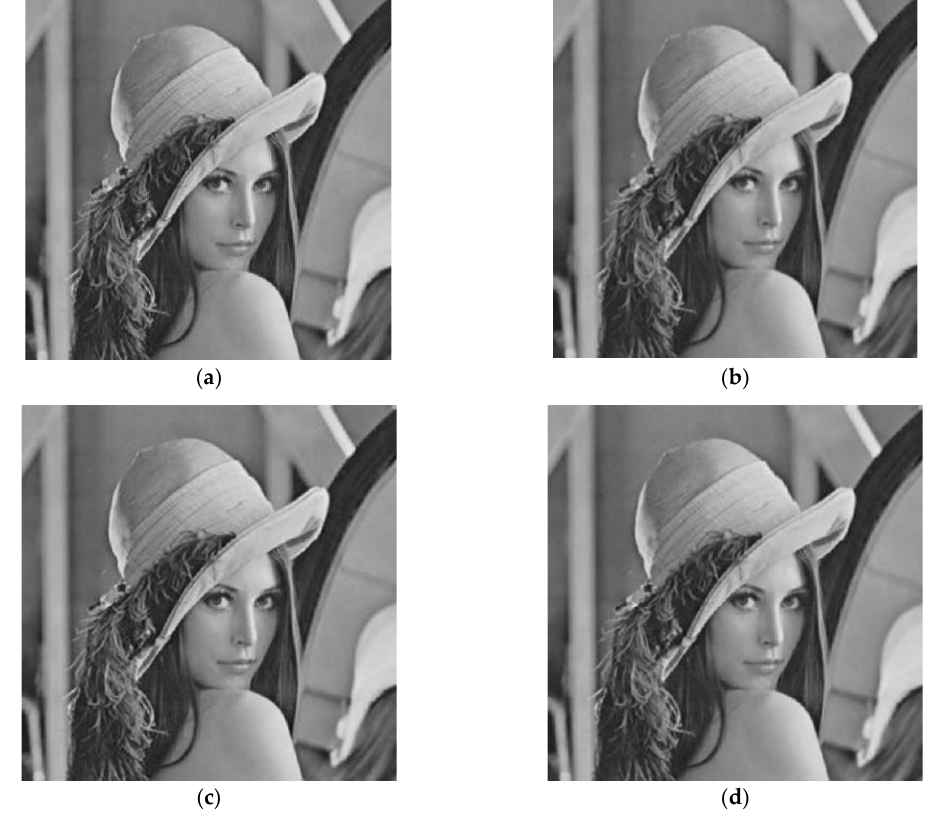
Figure 3. The zoomed images by factor 2 based on four different interpolant methods. ( a ) The zoomed images by factor 2 based on the nearest-neighbor interpolation method, ( b ) the zoomed images by factor 2 based on the bilinear interpolation, ( c ) the zoomed images by factor 2 based on the bicubic interpolation, ( d ) the zoomed images by factor 2 based on the proposed method.